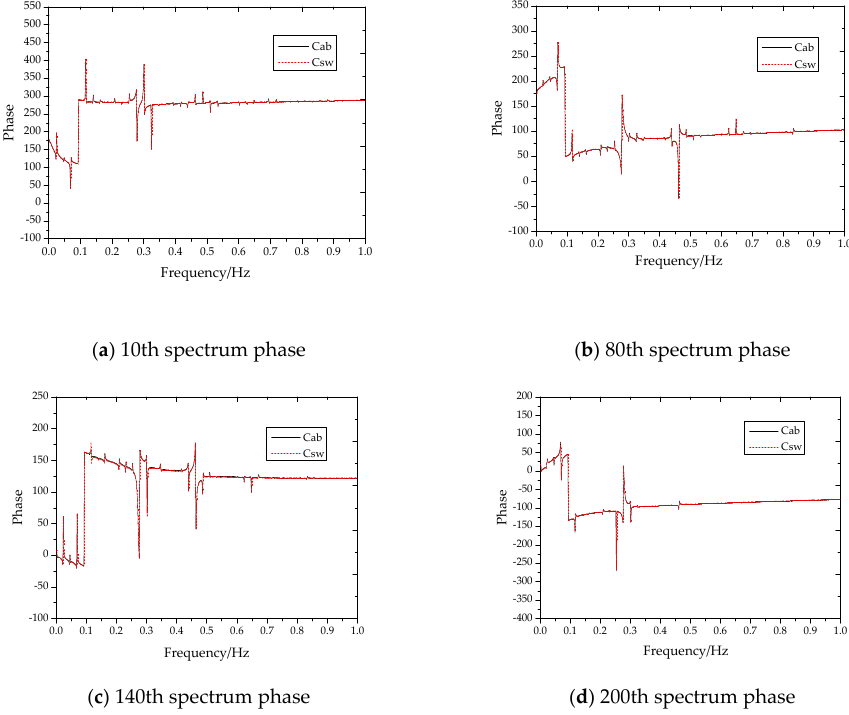
Figure 18. 10th – 200th spectrum phase of condition 1. Figure 18. 10th–200th spectrum phase of condition